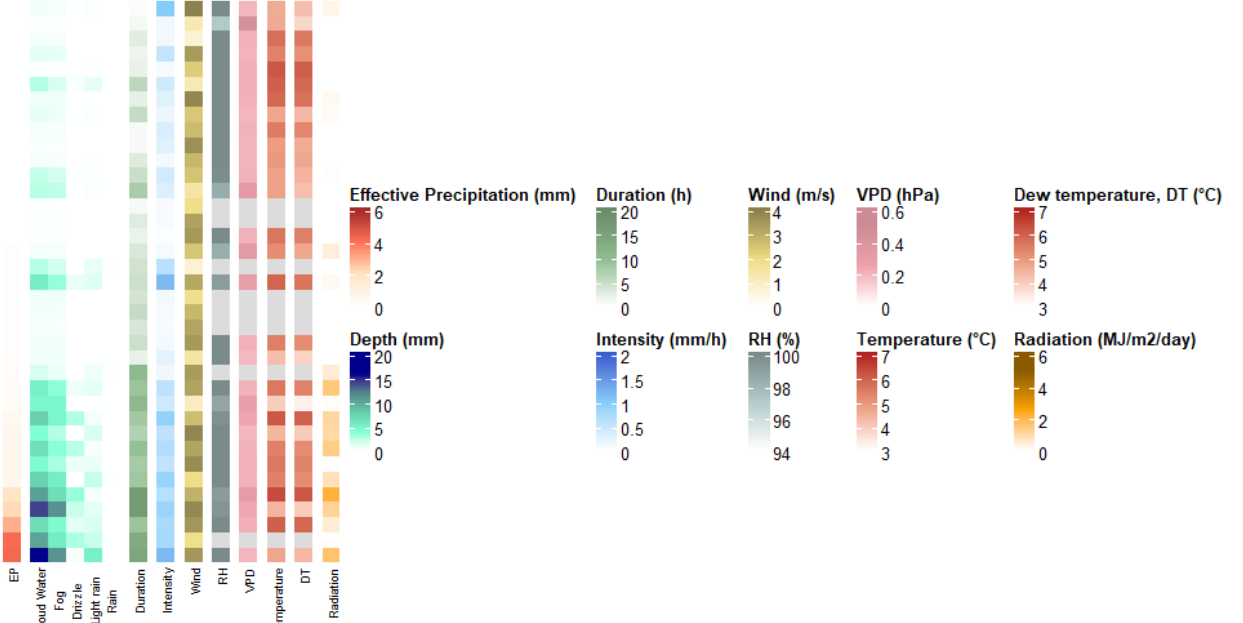
Figure A1. Heat-map for fog-only events as they relate to effective precipitation, the event charac- teristics, and the meteorological variables (wind, relative humidity, vapor pressure deficit, temper- ature, dew temperature, and radiation) analyzed to find an influence on soil moisture gain. Each bar represents a FO event and they are organized by effective precipitation increasing values.